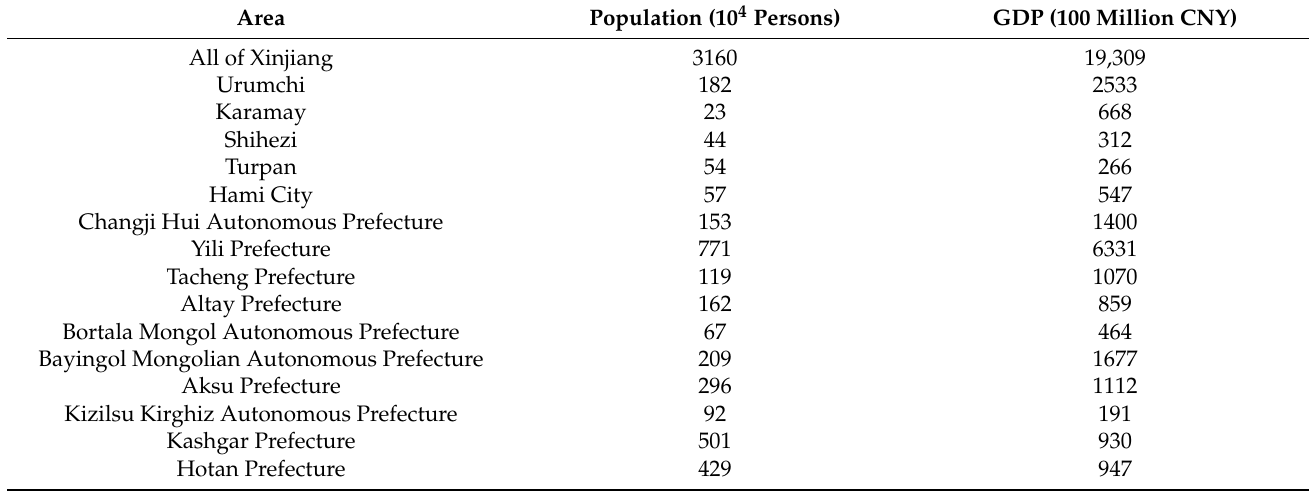
Table 1. The calculated water carrying capacity of Xinjiang in 2018.